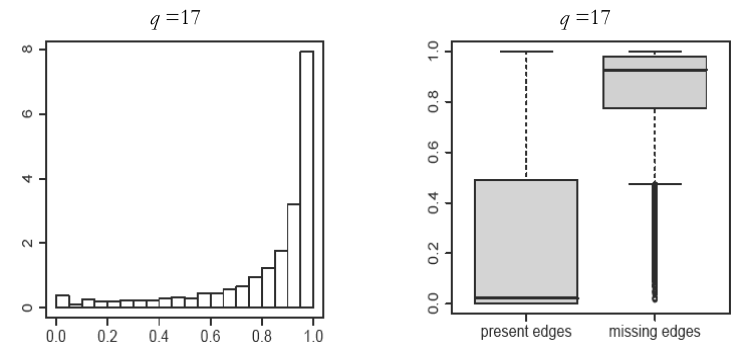
Figure 8 – qp -hist plot and associated distributions of the non-rejection rate for present and missing edges of G 1 = ( V , E 1 ), resulting from the application of the qp -procedure where n =150 and q =17.